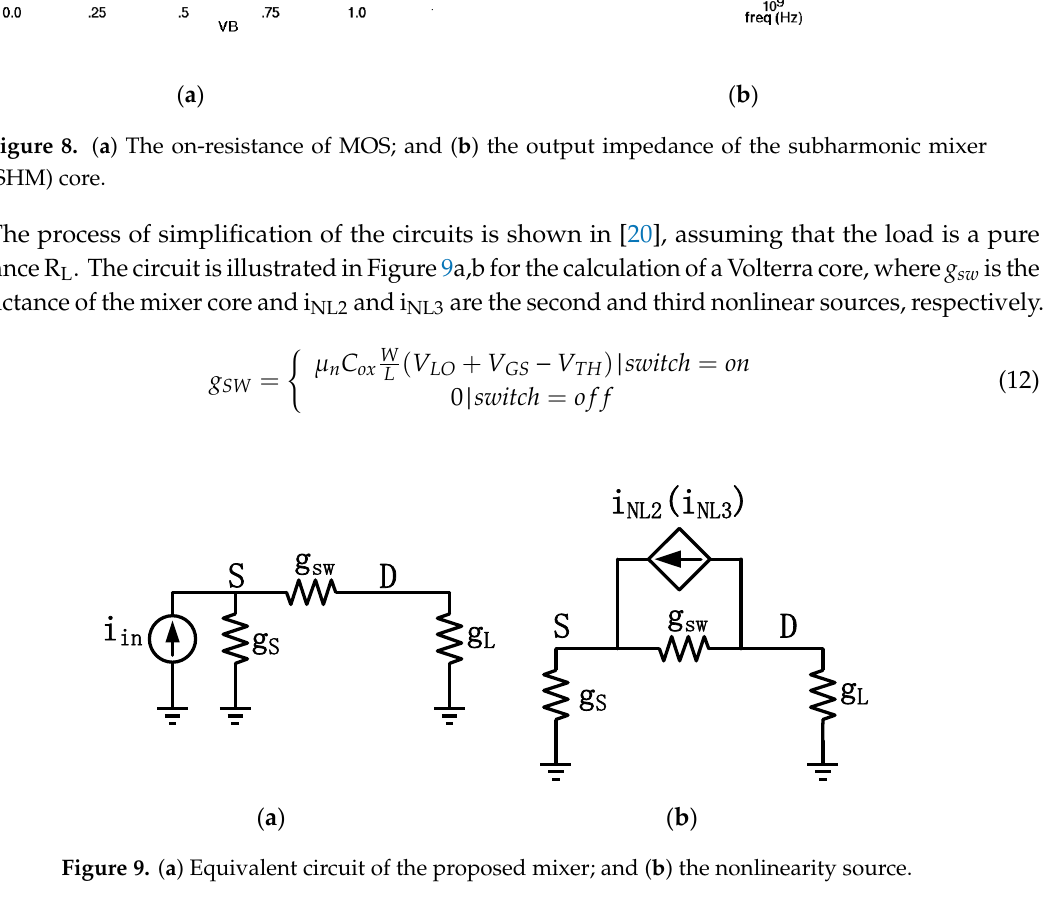
Figure 9. ( a ) Equivalent circuit of the proposed mixer; and ( b ) the nonlinearity source.